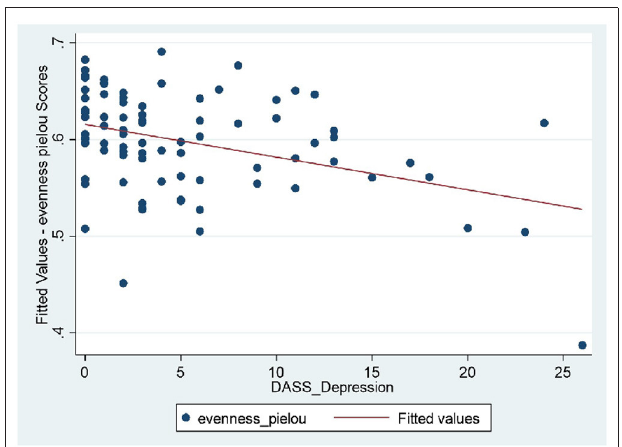
FIGURE 3 | UC patients: strong negative relationship between microbial evenness and depression scores ( p < 0.001), meaning that lower microbial evenness was strongly associated with higher depression scores in UC cohort.